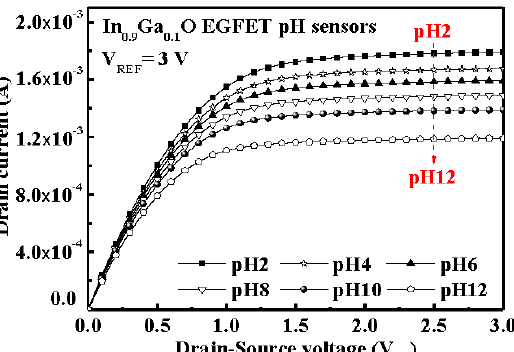
Figure 5. The drain current ( I DS ) and drain–source voltage ( V DS ) of the In 0.9 Ga 0.1 O EGFET pH sensors. Figure 5. The drain current ( 𝐼 Figure 5. The drain current ( 𝐼 (cid:3005)(cid:3020) ) and drain–source voltage ( 𝑉 (cid:3005)(cid:3020) ) of the In 0.9 Ga 0.1 O EGFET pH sensors. (cid:3005)(cid:3020) ) and drain–source voltage ( 𝑉 (cid:3005)(cid:3020) ) of the In 0.9 Ga 0.1 O EGFET pH sensors.